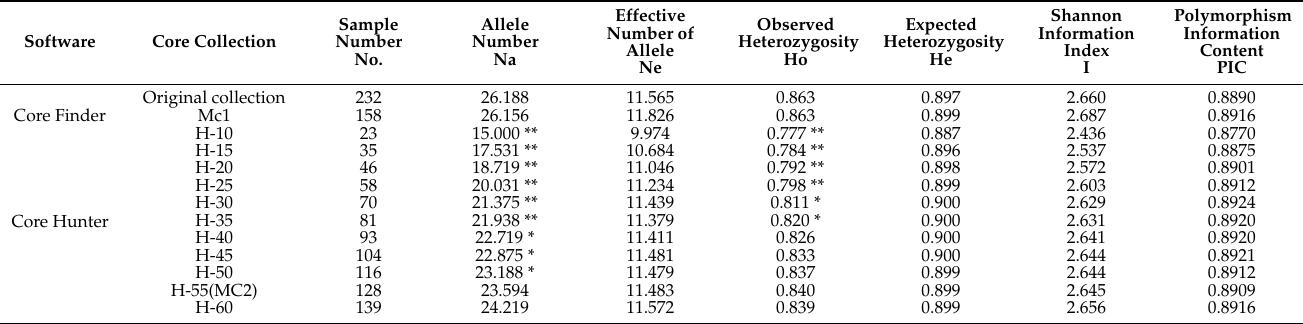
Table 6. Genetic parameters of the original and core collections.